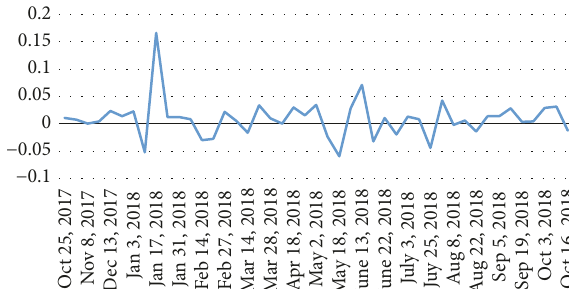
Figure 10: Oil price fluctuation (October 25, 2017, to October 16,